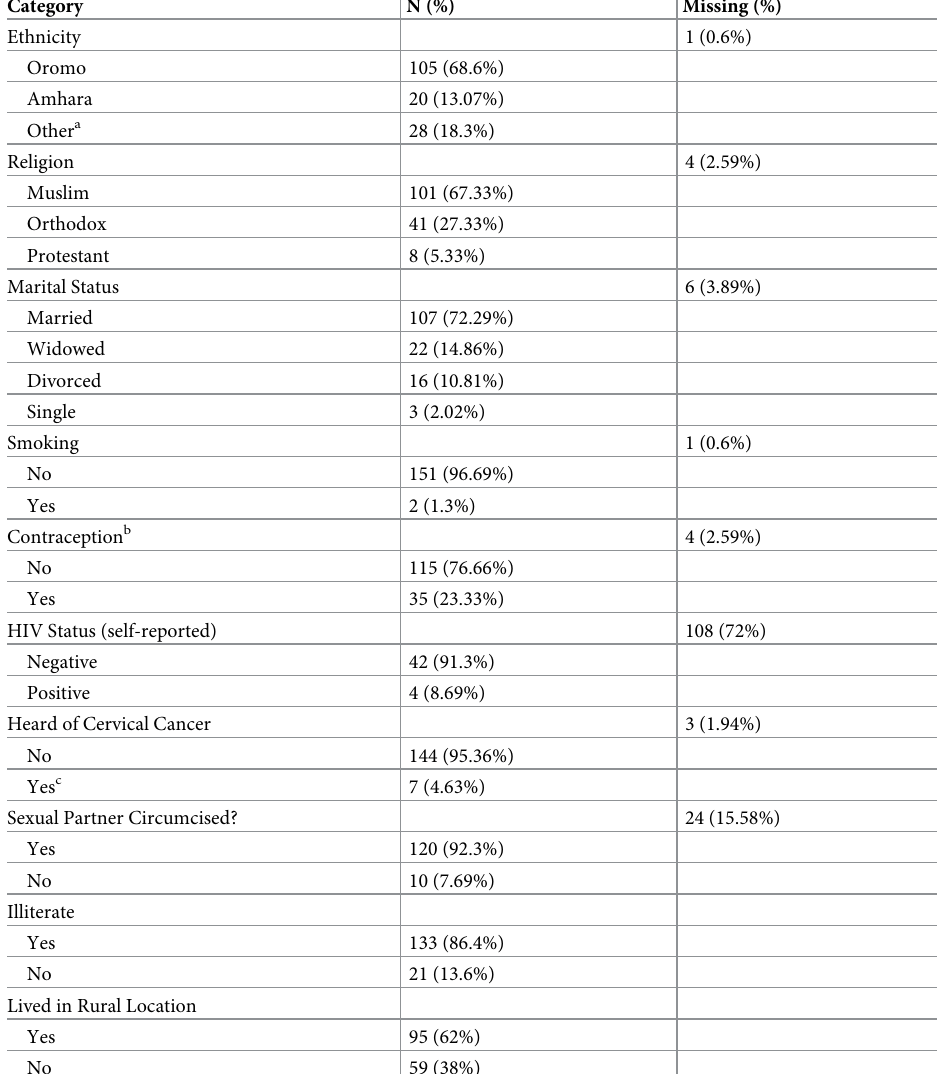
Table 2. Selected non-quantifiable demographic and clinical features of 154 cervical cancer cases at the Jimma University Teaching Hospital, Ethiopia from January 2008—December 2010. Category N (%) Missing